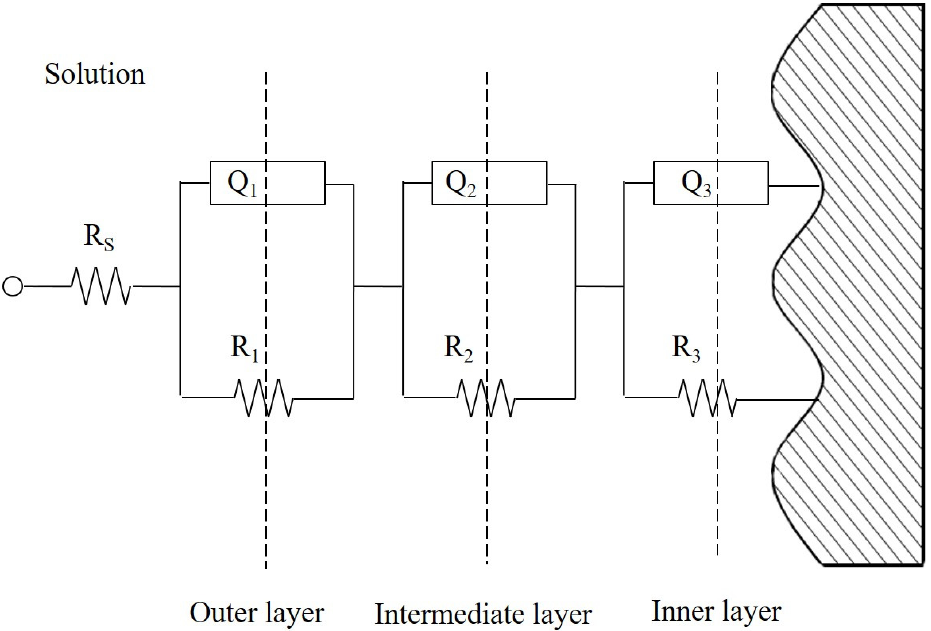
Figure 6. Equivalent circuit for fitting the impedance spectra of cp-Ti and Ti-Sn alloys. R s , R 1 , R 2 , and R 3 are the resistance of solution, outer layer, intermediate layer, and inner layer, respectively. Q 1 , Q 2 , and Q 3 are the CPEs of the outer, intermediate, and inner layers, respectively.